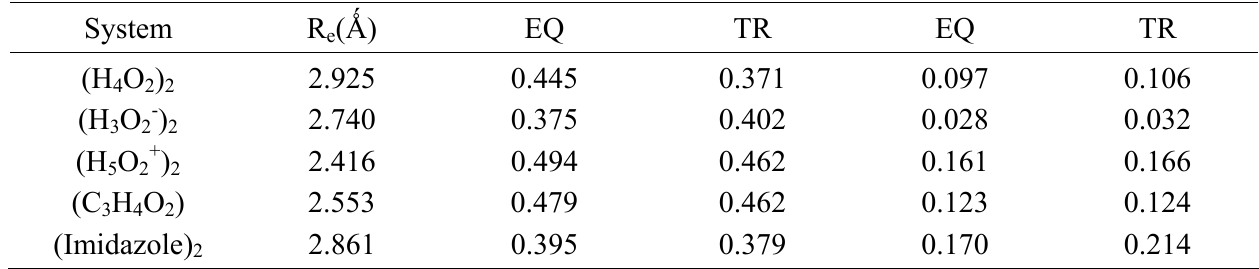
Table 4. Mulliken and Hirshfeld ground state HB proton charges in model systems within 6-31G** basis set for standard (EQ) and middle hydrogen bond proton positions (TR)